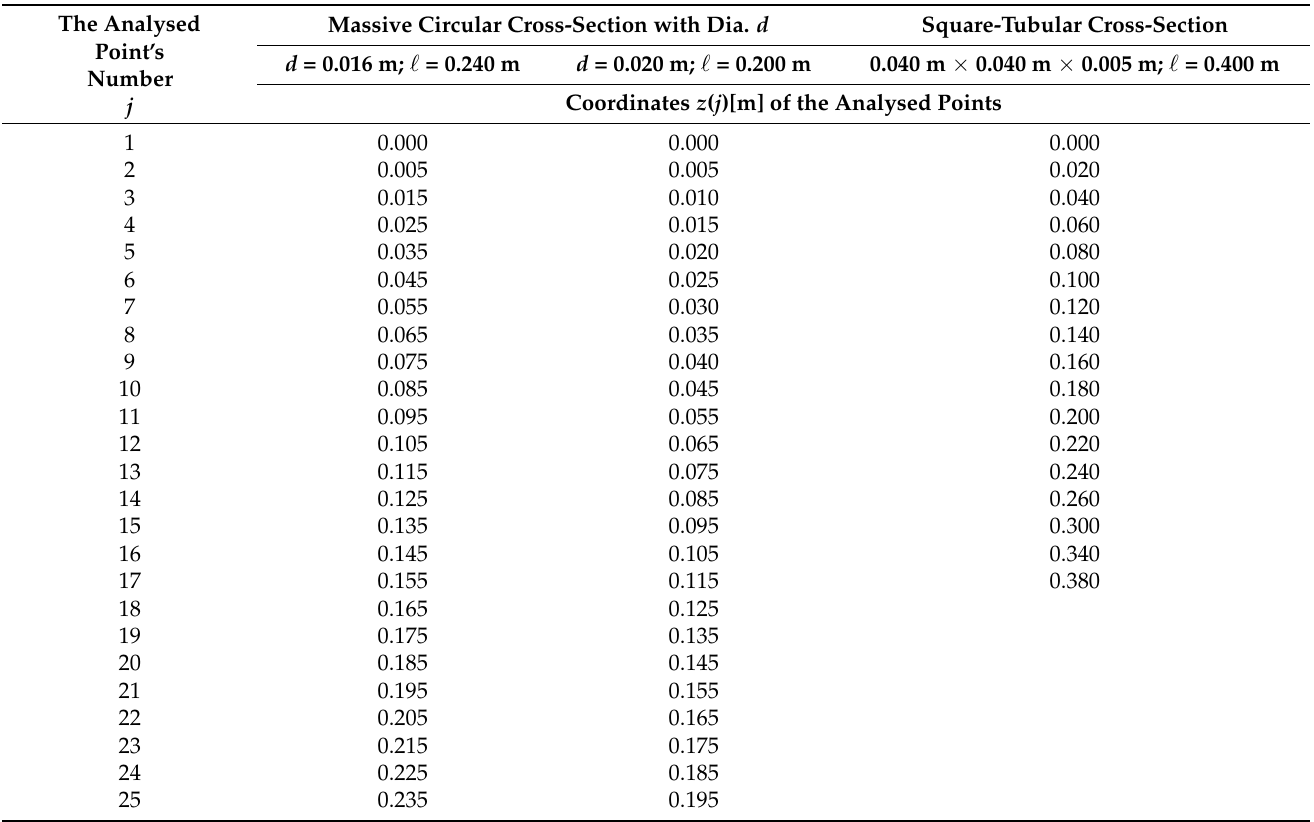
Table 1. Coordinates of the analyzed